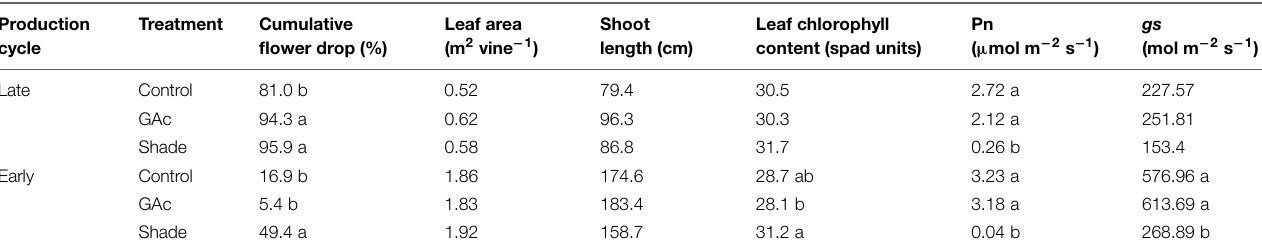
TABLE 1 | Effect of shade and GAc treatments on the average percentage of flower drop, total leaf area, and estimated leaf chlorophyll content at 12 DAB, on net photosynthetic rate (Pn) and gs during the shade period in ‘Black Magic’ vines in late and early cycles. Production cycle